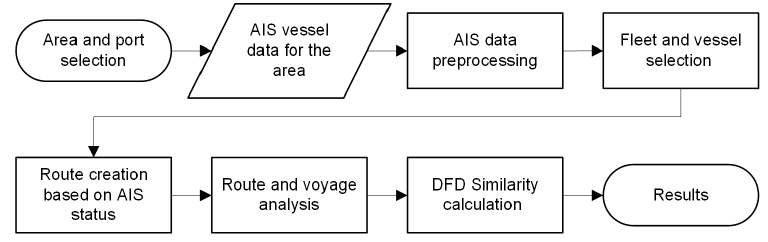
Figure 1. Methodology overview.